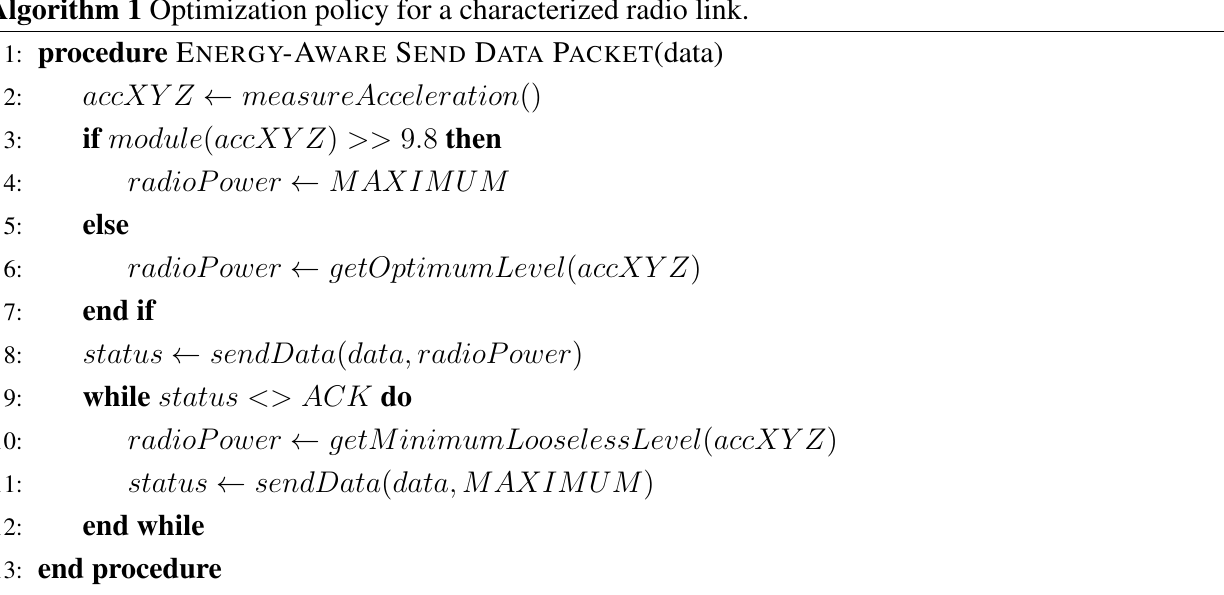
Algorithm 1 Optimization policy for a characterized radio